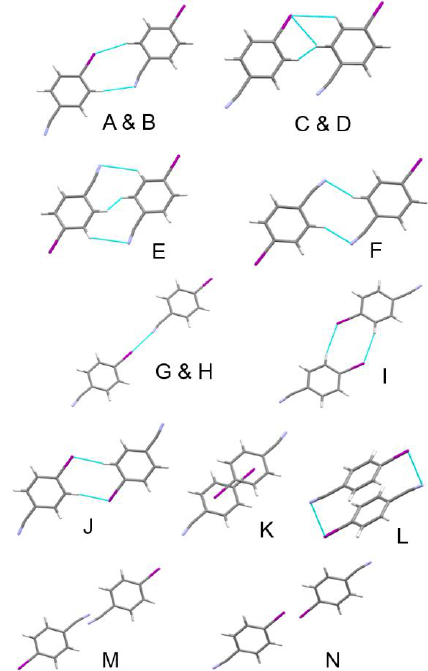
Figure 12. The most energetically significant dimers in the phase II structure of 4-iodobenzonitrile at 5.5 GPa.